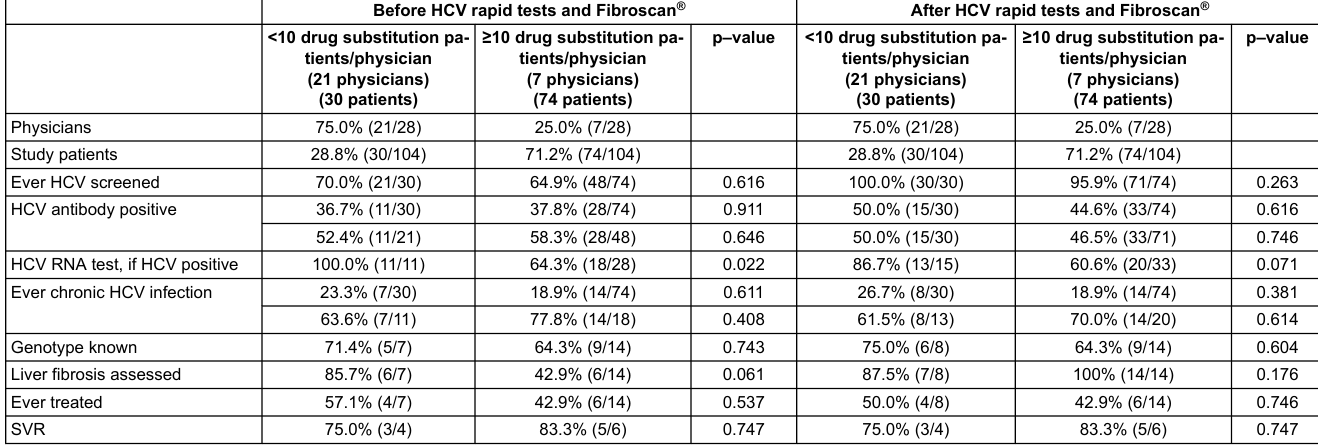
Table S1: HCV cascade of patients cared for by physicians with <10 versus ≥10 drug substitution patients in the decentralised setting, before and after HCV rapid tests and Fi- broscan ® .